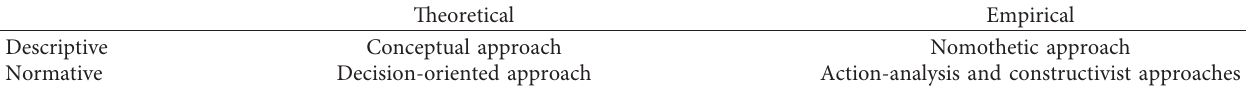
Table 1: The 5 groups of research methodologies according to